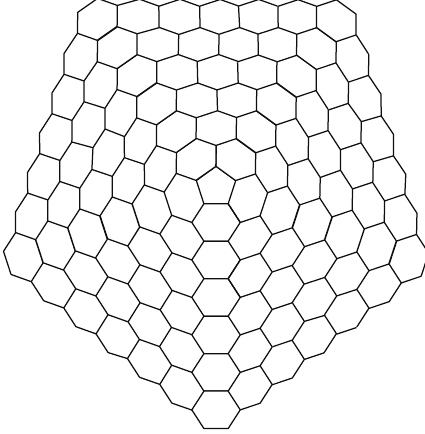
Figure 1: The molecular structure of pentagonal carbon nanocone PCN 5 [𝑛]